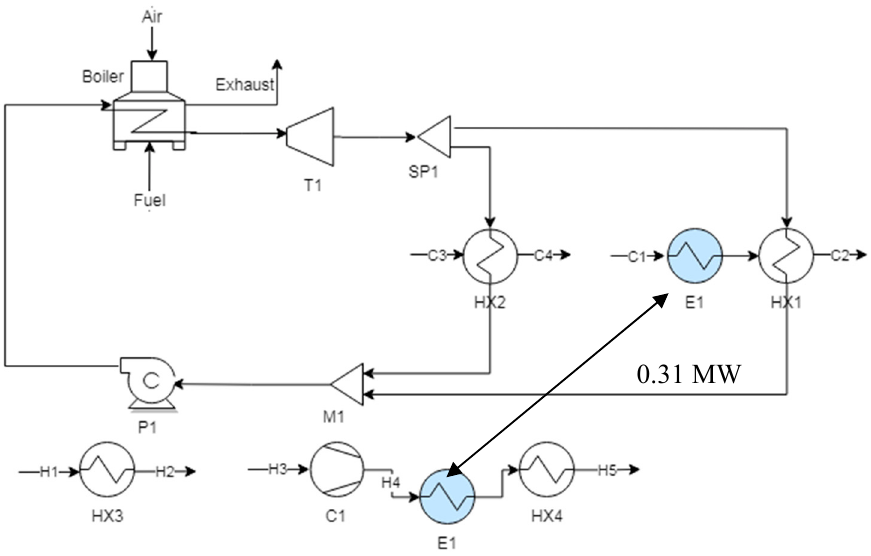
Figure 7 . Pinch analysis of the base case study